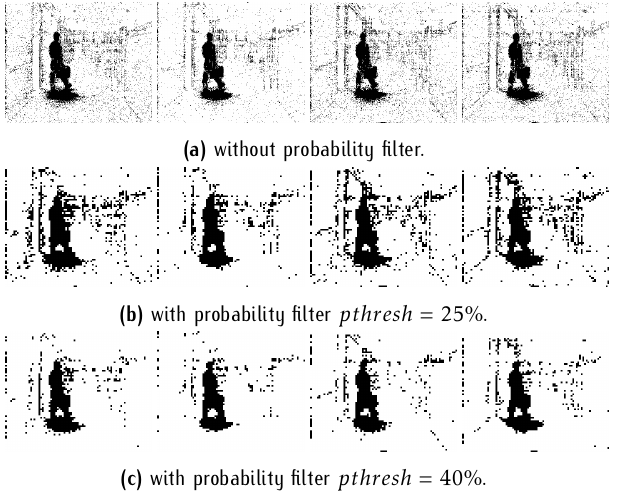
Figure 5. Zipfian Estimation without/with the probability filter.